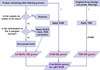
Q-Q plot showing the distribution of the log10-expression values of all probes in each sample (y-axis), compared to a theoretical normal distribution (x axis), for diseased (upper) and healthy controls (lower).